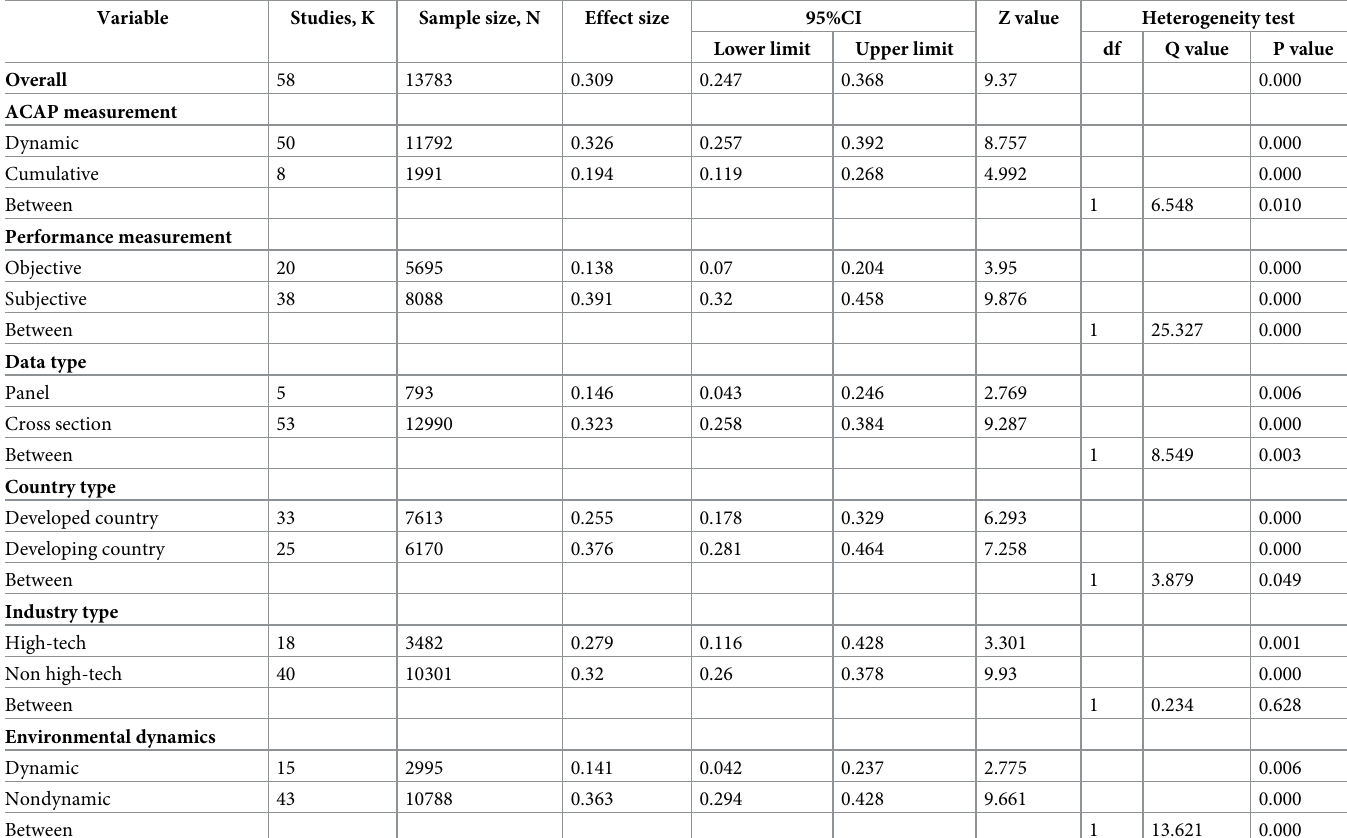
Table 2. Meta-subgroup test